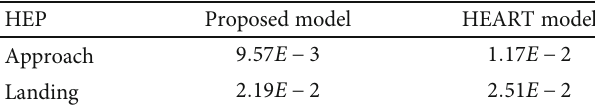
Figure 4: Relations among landing operations. Table 11: HEPs of the approach and landing